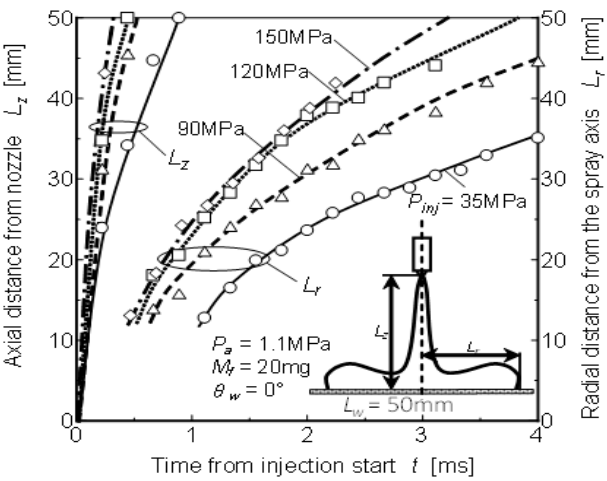
Figure 14. Spray tip penetration after wall impingement.